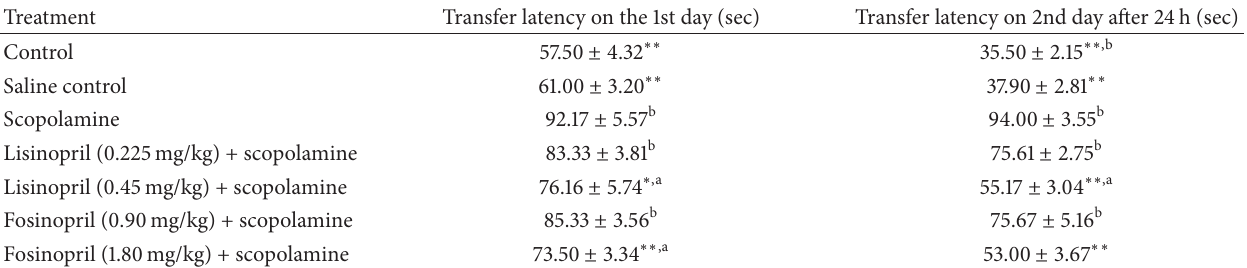
Table 1: Effects of lisinopril and fosinopril on the transfer latencies on 1st day and 2nd day in elevated plus maze test.